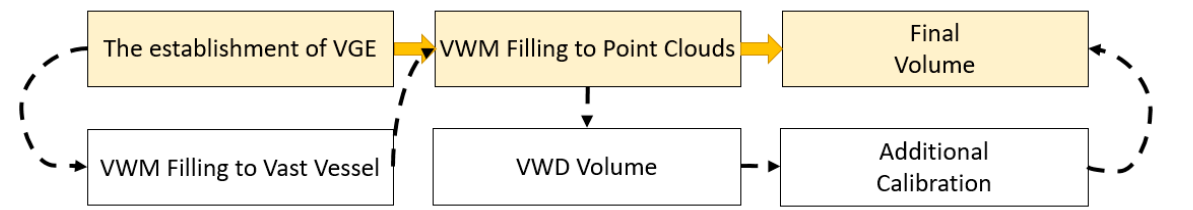
Figure 7. Theoretical (yellow) and full workflow for virtual water displacement (VWD) simulation.